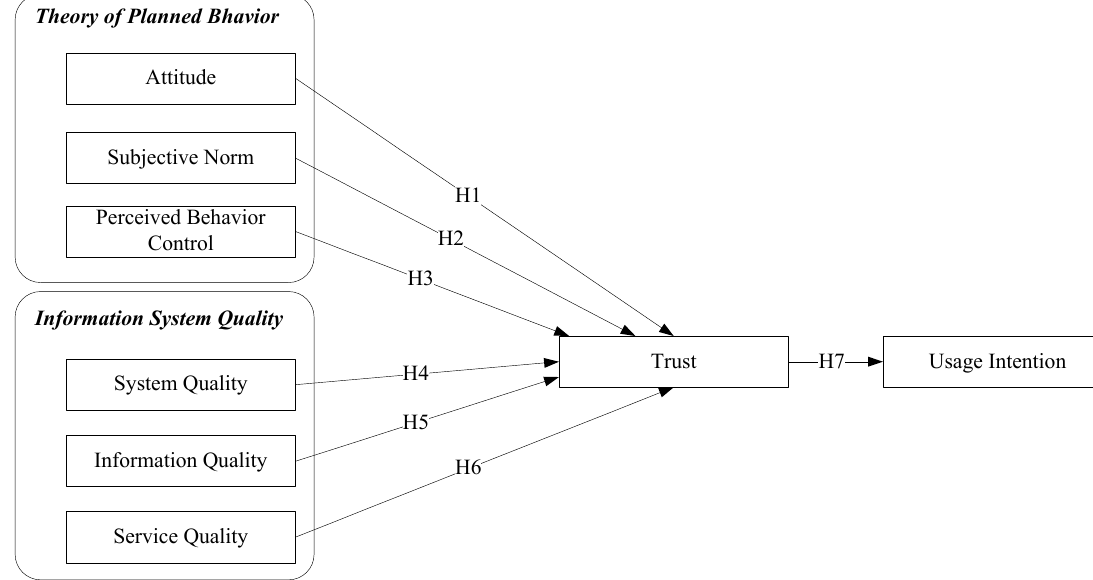
Figure 1. Research model.